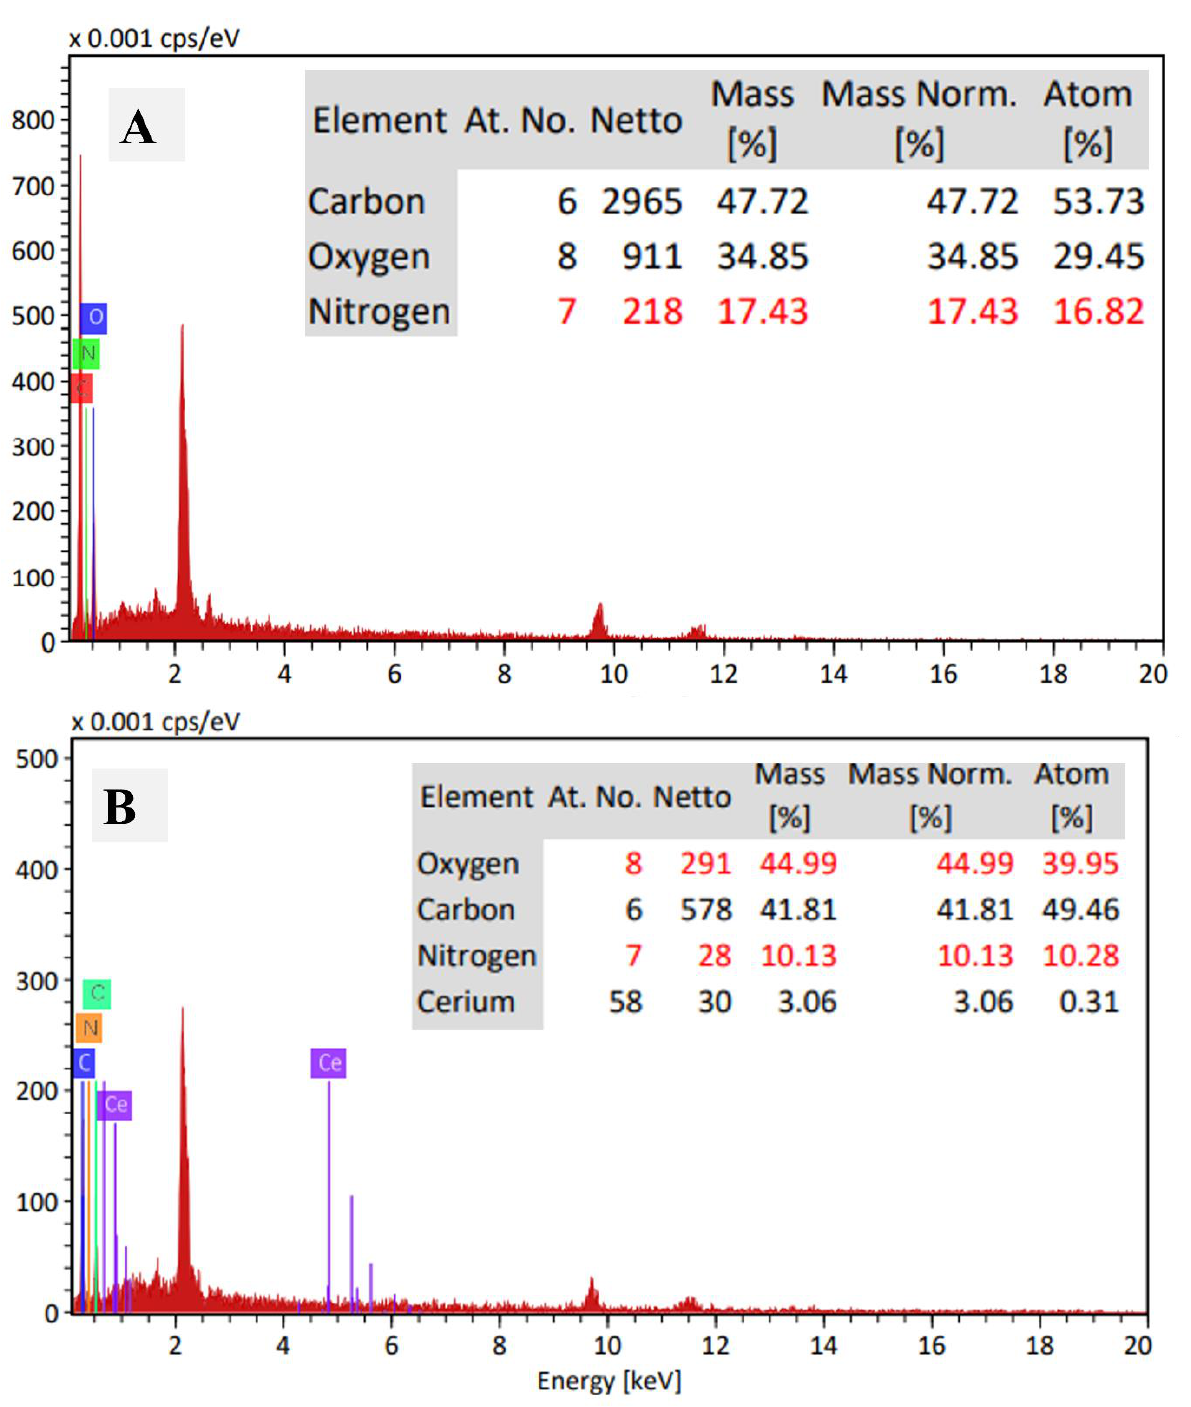
Figure 2. EDX of gelatin ( A ) and 5% CeO 2 @gelatin ( B ), and the inset is the chemical elemental analysis based on EDX peaks analysis.